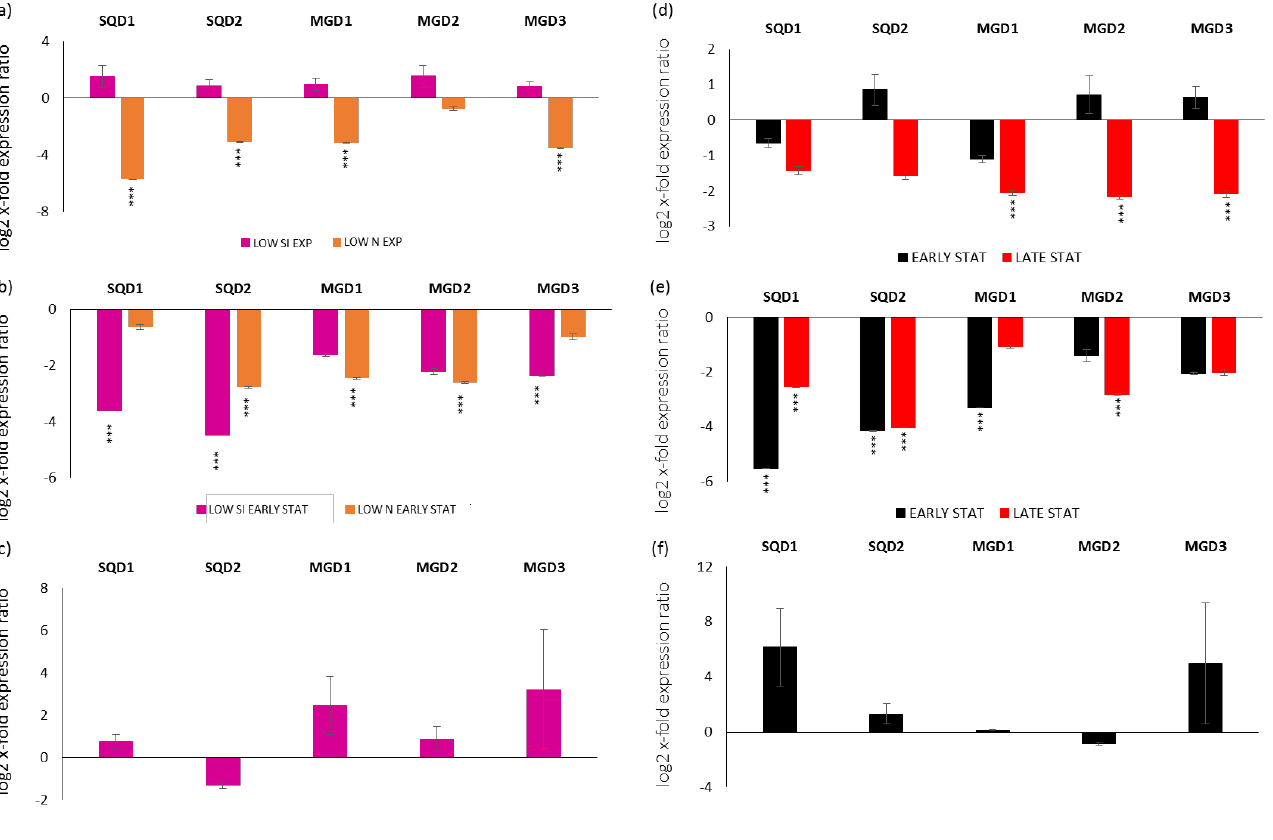
Figure 2. Expression levels of genes involved in sulfoquinovosyldiacylglycerol and monogalacto- syldiacylglycerol synthesis in P. tricornutum cells in ( a ) LOW SI and LOW N exponential phase compared to the control condition (Replete condition exponential phase; x-axis); ( b ) LOW SI and LOW N early stationery phase compared to the control condition (Replete condition early stationery phase); ( c ) LOW SI late stationery phase compared to the control condition (Replete condition late stationery phase); ( d ) Replete condition early stationery and late stationery compared to the con- trol condition (Replete; x-axis) exponential phase; ( e ) LOW SI condition early stationery and late stationery compared to the LOW SI condition exponential phase; ( f ) LOW N early stationery phase compared to LOW N exponential phase. Data are represented as log2 x-fold expression ratio ± SD (n = 4; *** p < 0.001, Student’s t-test). Abbreviations stands for: UDP-sulfoquinovose synthase (SQD1), sulfoquinovosyldiacylglycerol synthase (SQD2), monogalactosyldiacylglycerol synthases 1, 2 and 3 (MGD1, MGD2 and MGD3,